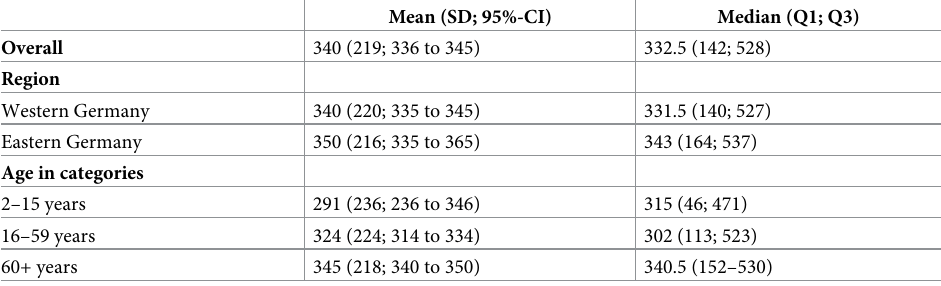
Table 4. Mean and median time to vaccination in days within 2 years after incident “high-risk”